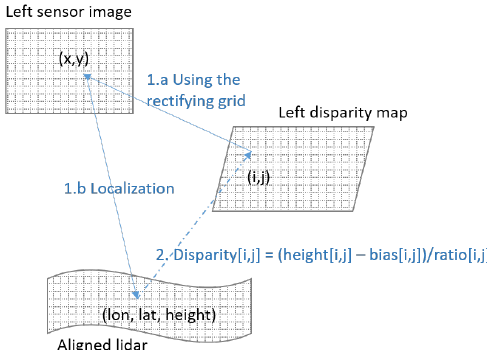
Figure 2. Overview of the disparity map generation process, that we call localization and height to disp , cf detailed description in 3.2.4